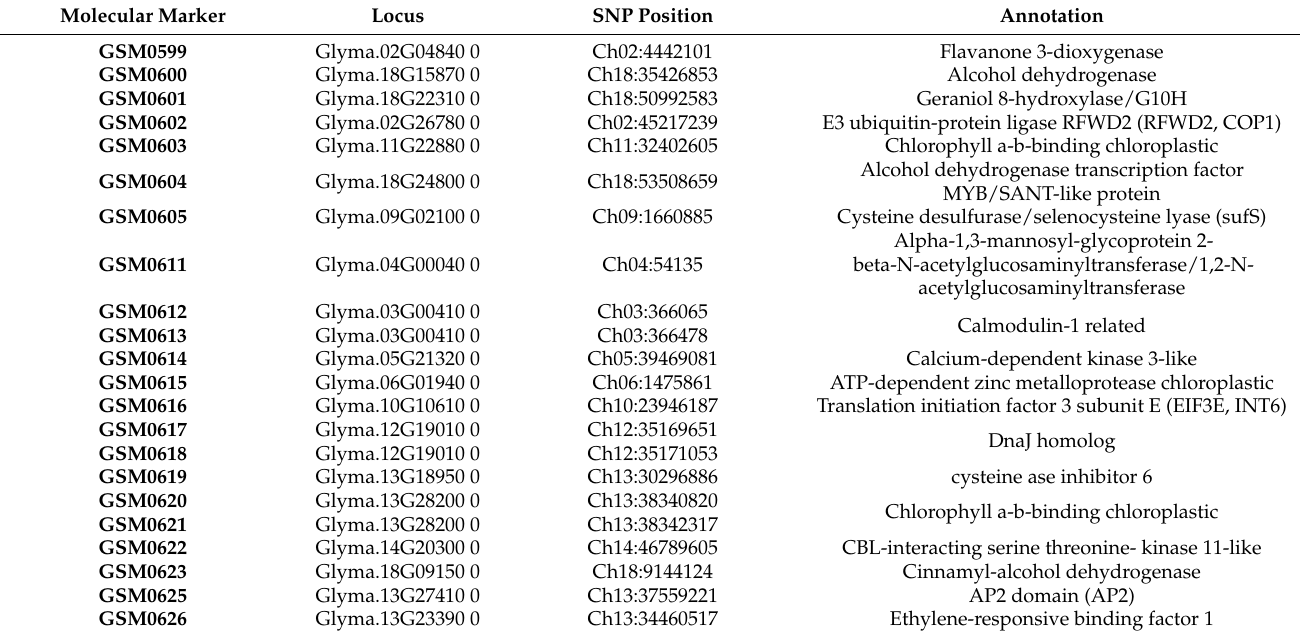
Table 3. List of SNPs selected for KASP